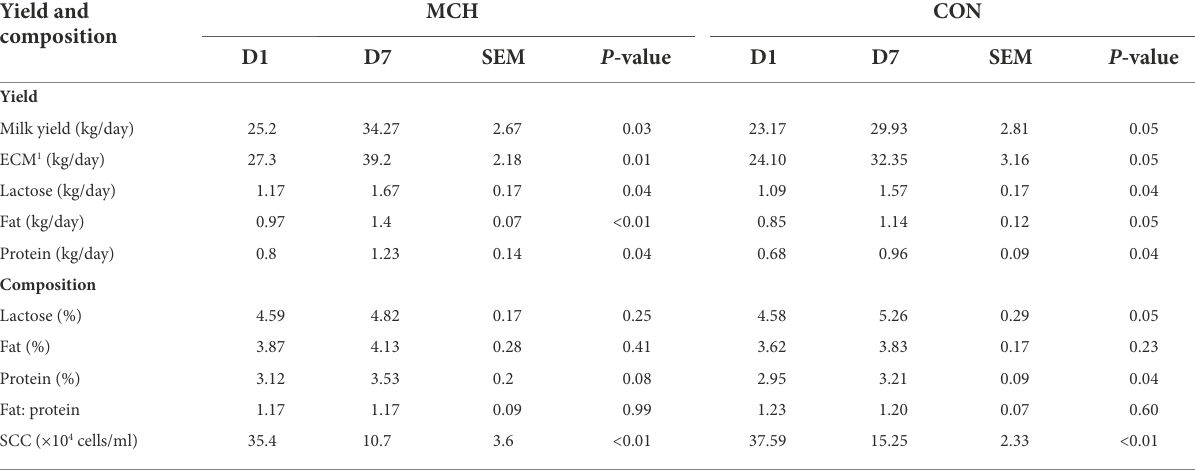
TABLE 2 Comparisons of milk yield and composition after intramammary treatment with matrine-loaded chitosan hydrogel ( n = 6). Yield and composition